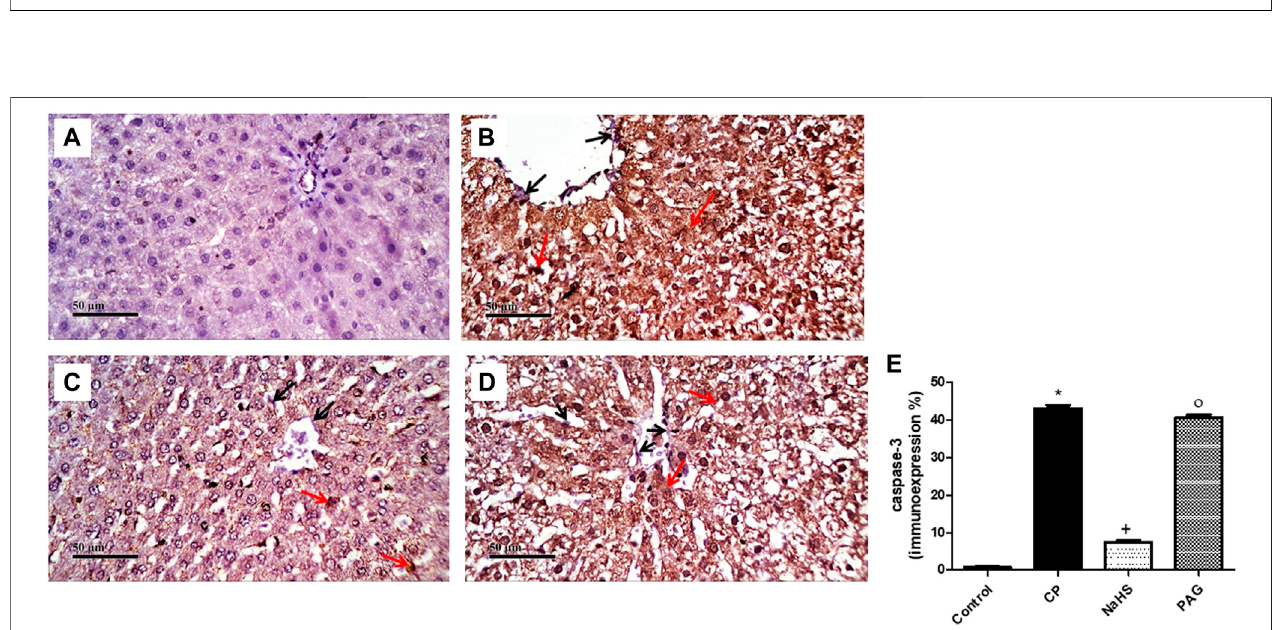
FIGURE 7 | Representative photomicrographs of immunohistochemical analysis of hepatic caspase-3 protein expression (A) Control group, (B) CP group, (C) NaHSgroup,and (D) PAGgroup.Allreactivehepatocytesarelabeledwithredarrows,whileblackarrowsindicatenegativereactivehepatocytes. (E) Asemi-quantitative analysisofcaspase-3 inrat ’ slivertissue.Dataarerepresented asmean±SEM.*, +, ° aresigni fi cantlydifferentfromcontrol,CPandNaHS groups,respectively,where n = 6 and p < 0.05. CP; Cyclophosphamide, PAG; DL-propargylglycine.